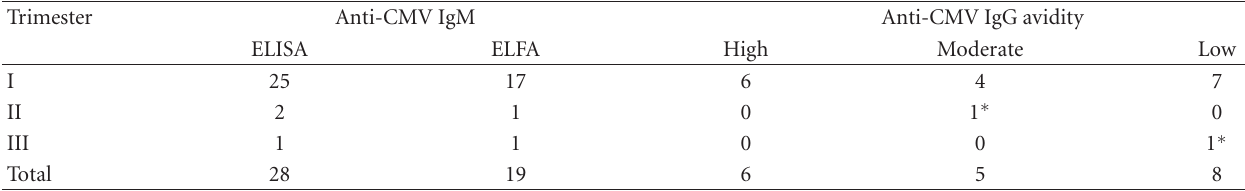
Table 4: IgM, ELFA, and IgG avidity in pregnant women by trimester of pregnancy.